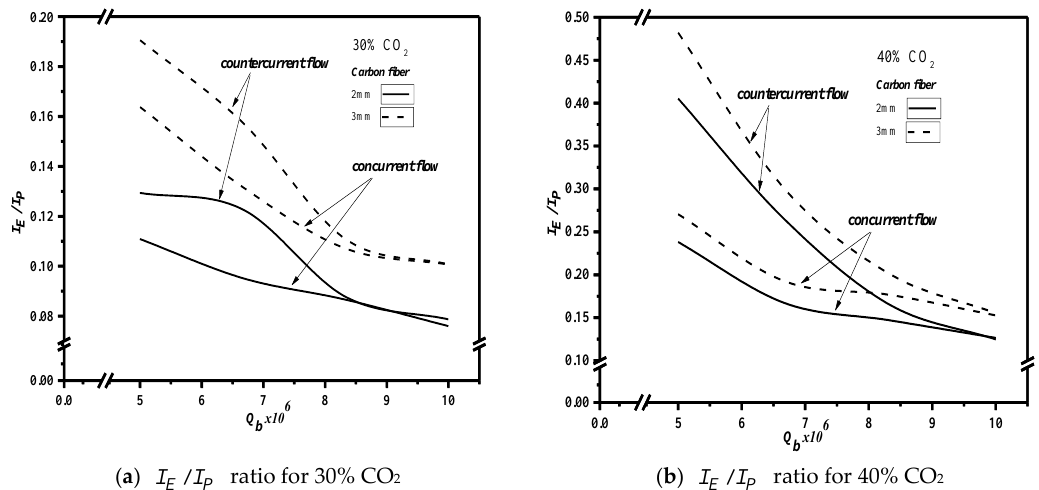
Figure 13. Effects of feed flow rate, spacers ’ width, and feed CO 2 concentration on PE II / . ( a ) P E I I / ratio for 30% CO 2 ; ( b ) PE II / ratio for 40% CO 2. ratio for 30% CO 2 ; ( b ) I E / I P ratio for 40% CO